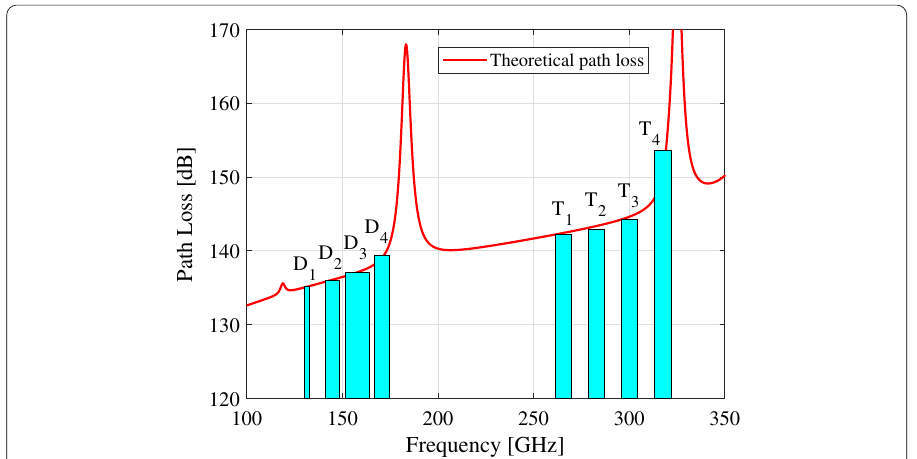
Fig. 8 Path losses for the bands considered in the link budget calculations. The exact path loss as a function of frequency versus the average losses per band given in Tables 1 and